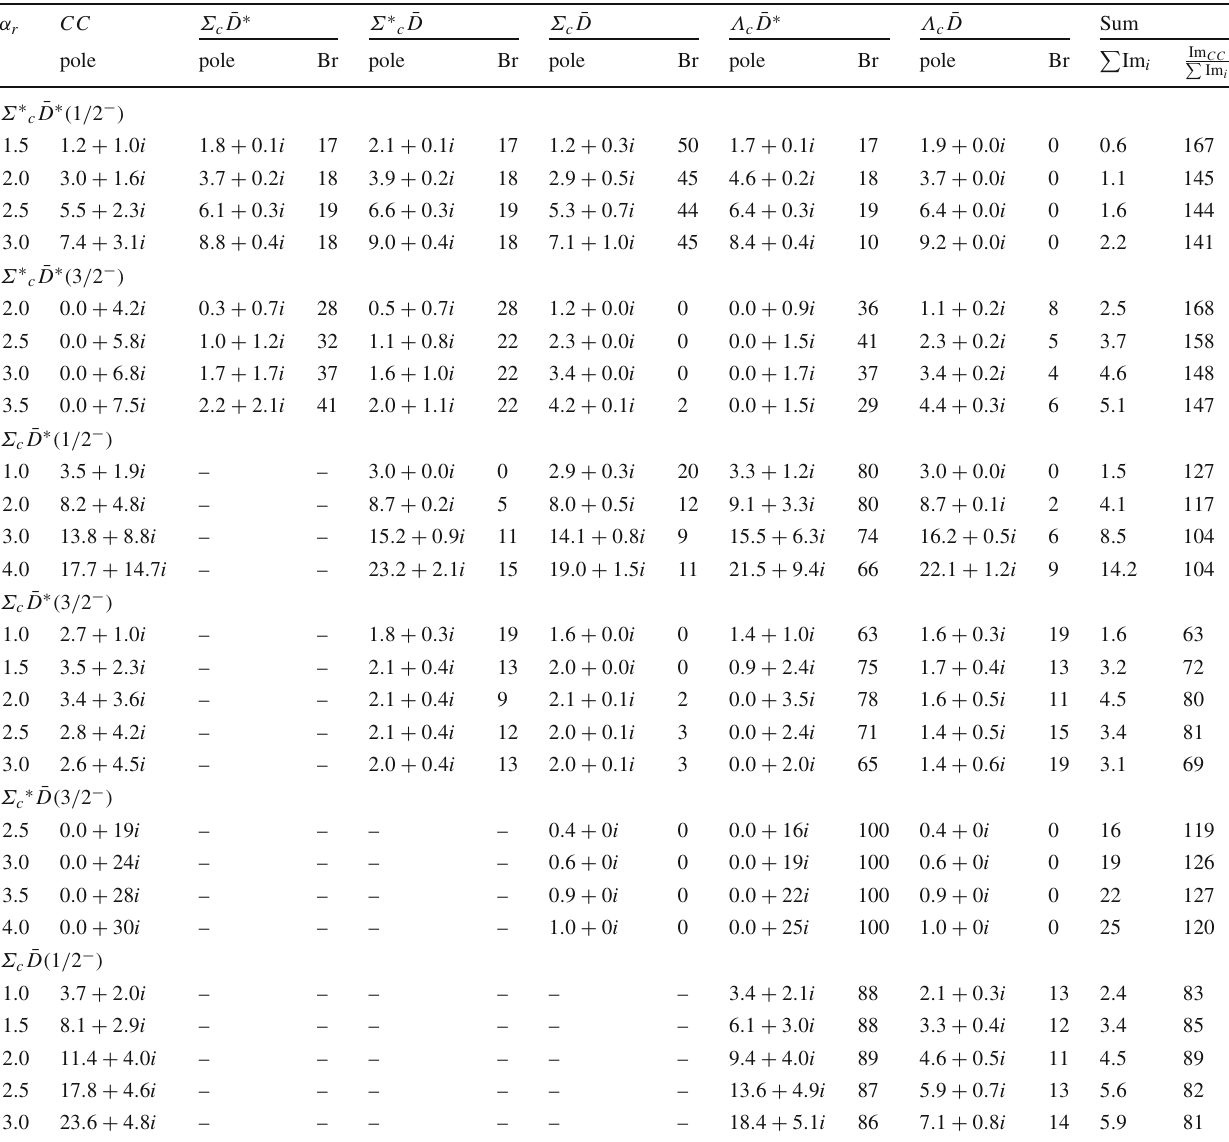
M th − z , in the unit of MeV and Br = Im i (cid:18) for i channel in the unit Im i of %. The α r is the cutoff in the exponential regularization in Eq. (19). The explicit explanation can be found in the